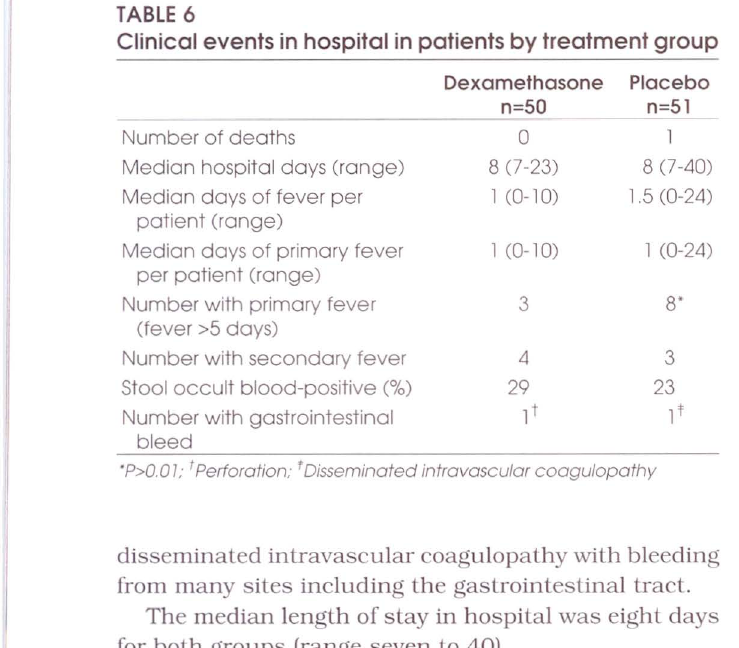
Clinical events in hospital in patients by treatment group